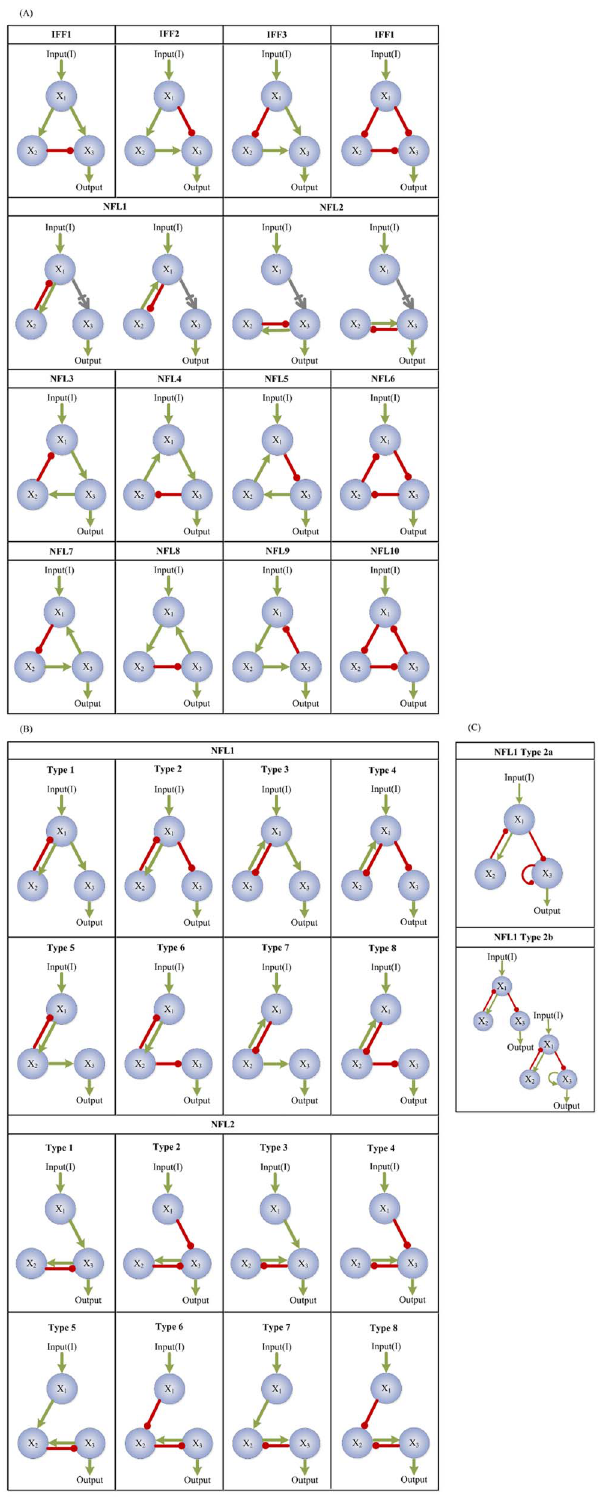
Figure 5. Illustrating the different types of tested motifs. The red, green, and gray arrows indicate deactivation, activation, or either activation or deactivation through a direct or indirect path, respectively. We test two known general motifs, the incoherent feedforward loop (IFF) and the negative feedback loop (NFL). (A) All possible IFF and NFL motifs. (B) All 8 possibilities (types) each for the NFL1 and NFL2 motifs. (C) NFL1 Type2 subtypes.